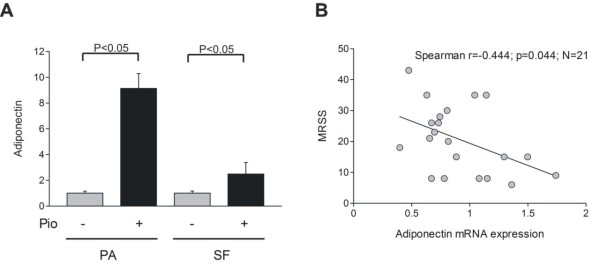
Adiponectin mRNA regulation. (a) Confluent human skin fibroblasts (SFs) or subcutaneous preadipocytes (PAs) were incubated with 10 μM pioglitazone (Pio) for 48 hours, and RNA was examined by real-time quantitative polymerase chain reaction. The results, normalized with glyceraldehyde-3-phosphate dehydrogenase mRNA levels, represent the mean ± standard deviation of triplicate determinations. (b) Adiponectin mRNA levels in systemic sclerosis skin biopsies. The data were extracted from published genome-wide expression microarray datasets [16]. Levels were correlated with modified Rodnan skin score (MRSS).